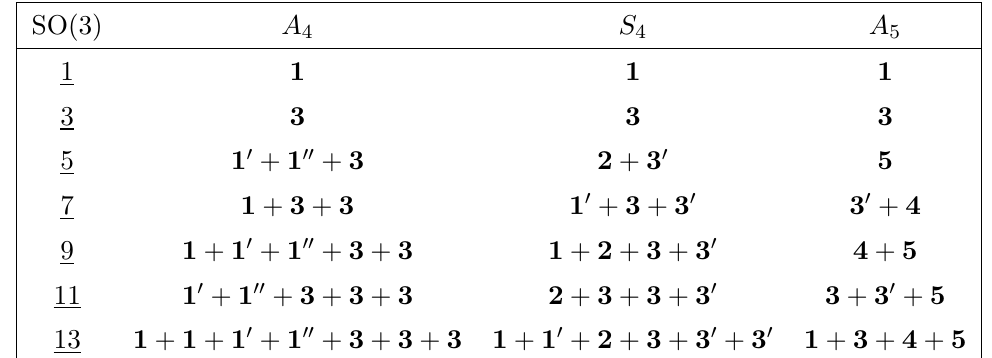
Table 2 . Decomposition of some irreps of SO(3) into irreps of A position to irreps of A 4 have been given in